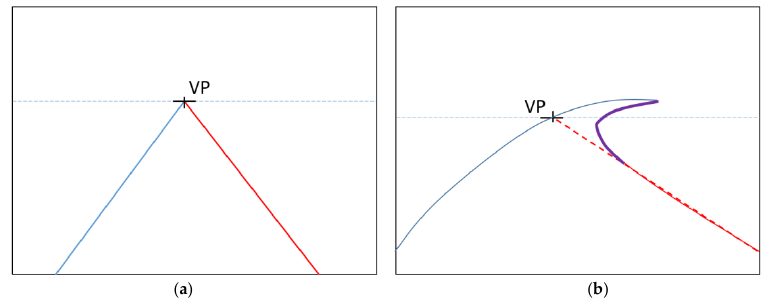
Figure 16. Detected vanishing point. VP means the detected vanishing point: ( a ) straight road lane markings; ( b ) curved lane markings.